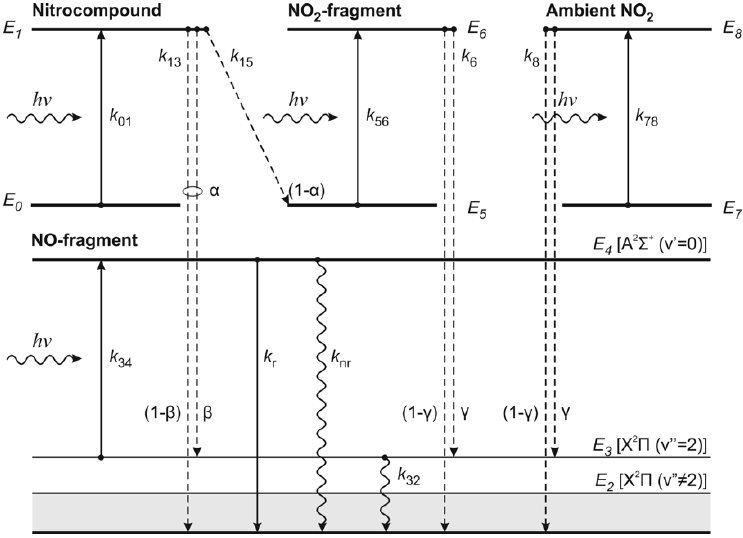
Figure 1. Schematic diagram of energy levels of molecules involved in the laser fragmentation/laser-induced fluorescence (LF/LIF) process.